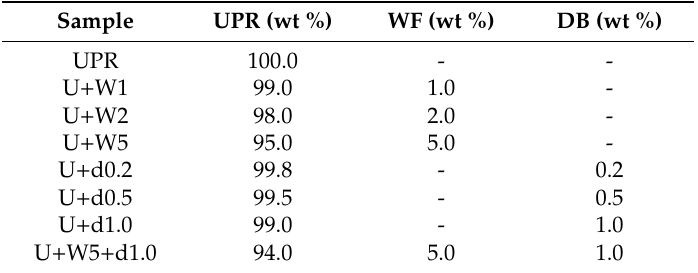
Table 1. Compositions of green